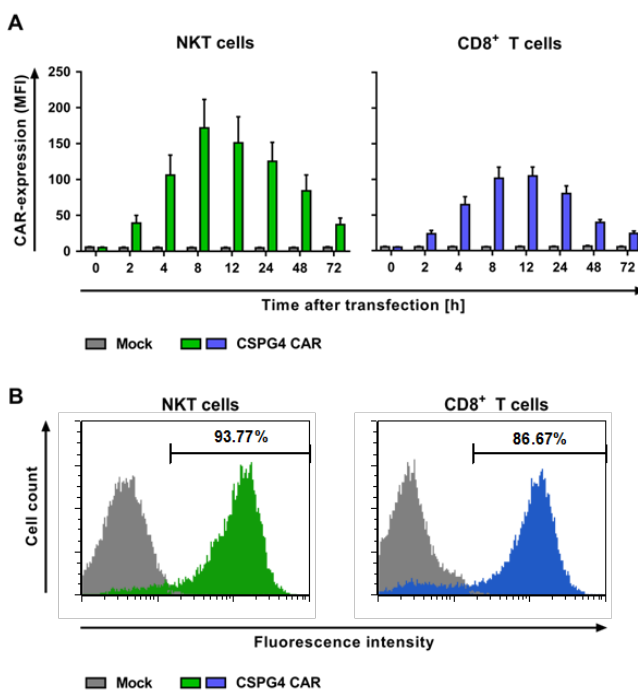
Figure 2. NKT cells can be efficiently transfected with a chondroitin sulfate proteoglycan 4 (CSPG4)-specific chimeric antigen receptor (CAR) using RNA electroporation. The NKT and CD8 + T cells were isolated and expanded as described in Figure 1. After 10–11 days, the cell populations were either transfected without mRNA (mock) as controls or with mRNA encoding a CSPG4-specific CAR. ( A ) The expression kinetics of the CAR-electroporated cells at indicated timepoints are shown. The CAR expression of the NKT (green bars) and CD8 + T cells (blue bars) was detected by using an anti-IgG1 antibody. The mock-transfected cells served as controls (grey bars). The data represent the average geometric mean values of 5–7 independent experiments with SEM. The p -values were calculated by unpaired Student’s t -test and are listed in Table S3. ( B ) Representative histograms at the peak of the CAR expression of both of the cell populations at 8 h after electroporation. The NKT cells are displayed as the green-filled histogram, and the CD8 + T cells as the blue-filled histogram. The mock-transfected cells served as controls (grey-filled histograms). The staining for the CAR expression was performed using the abovementioned antibody. The data of one representative out of 5–7 independent experiments are